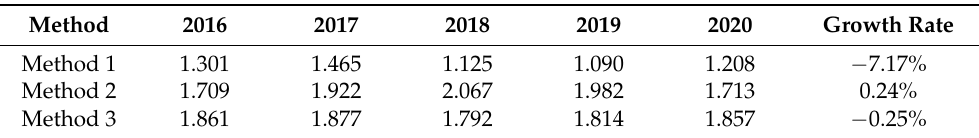
Table 1. Assessment the dynamics of sustainable development of the enterprise by three ways of calculating the SDI E (according the author’s